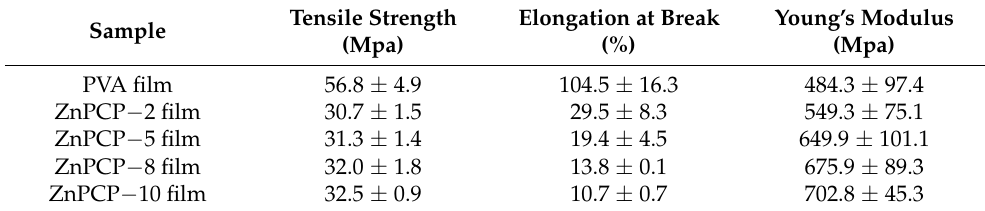
Figure 3. XPS spectra of ZnPCP − 10, including ( a ) survey, ( b ) C 1s, ( c ) O 1s and ( d ) Zn 2p. Table 1. The mechanical behavior of PVA film and